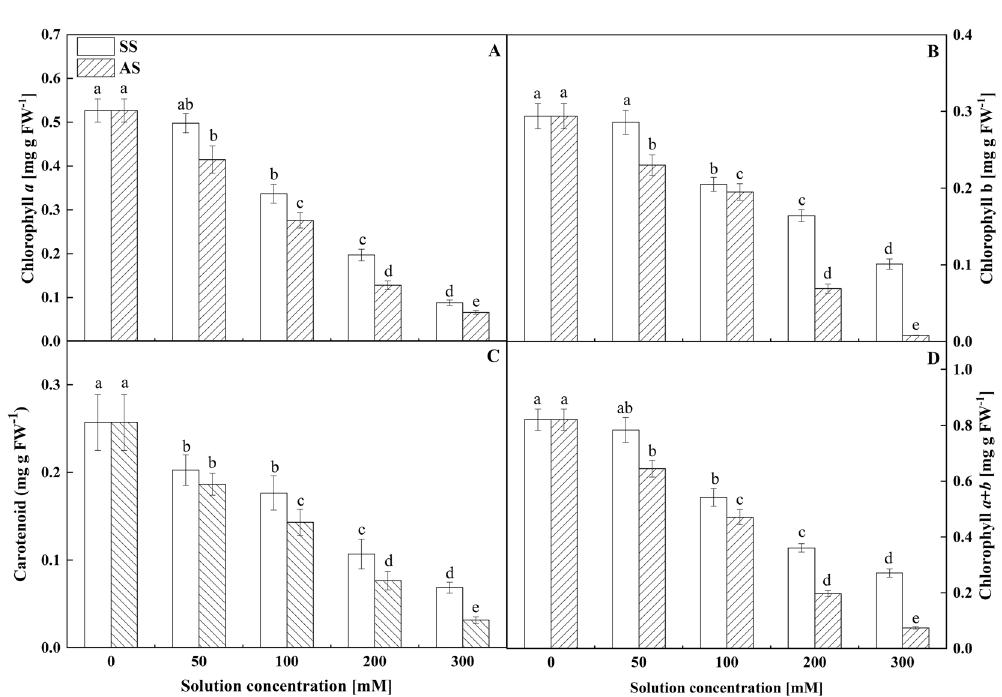
Figure 2. Effects of salt stress (SS) and alkali stress (AS) on the contents of ( A ) chlorophyll a, ( B ) chlorophyll b, ( C ) carotenoids and ( D ) chlorophyll (a + b). Means values indicated by different letters in the same curve are significantly different at P < 0.05 according to the least significant difference (LSD)